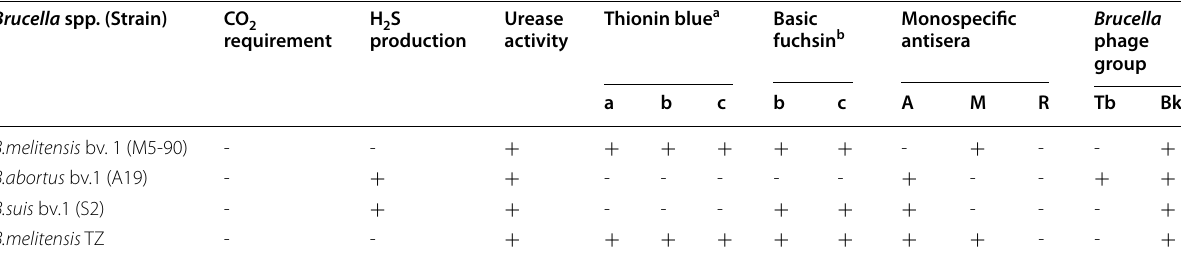
Note : , Positive. -, Negative. a Concentration of Thionin blue (a +